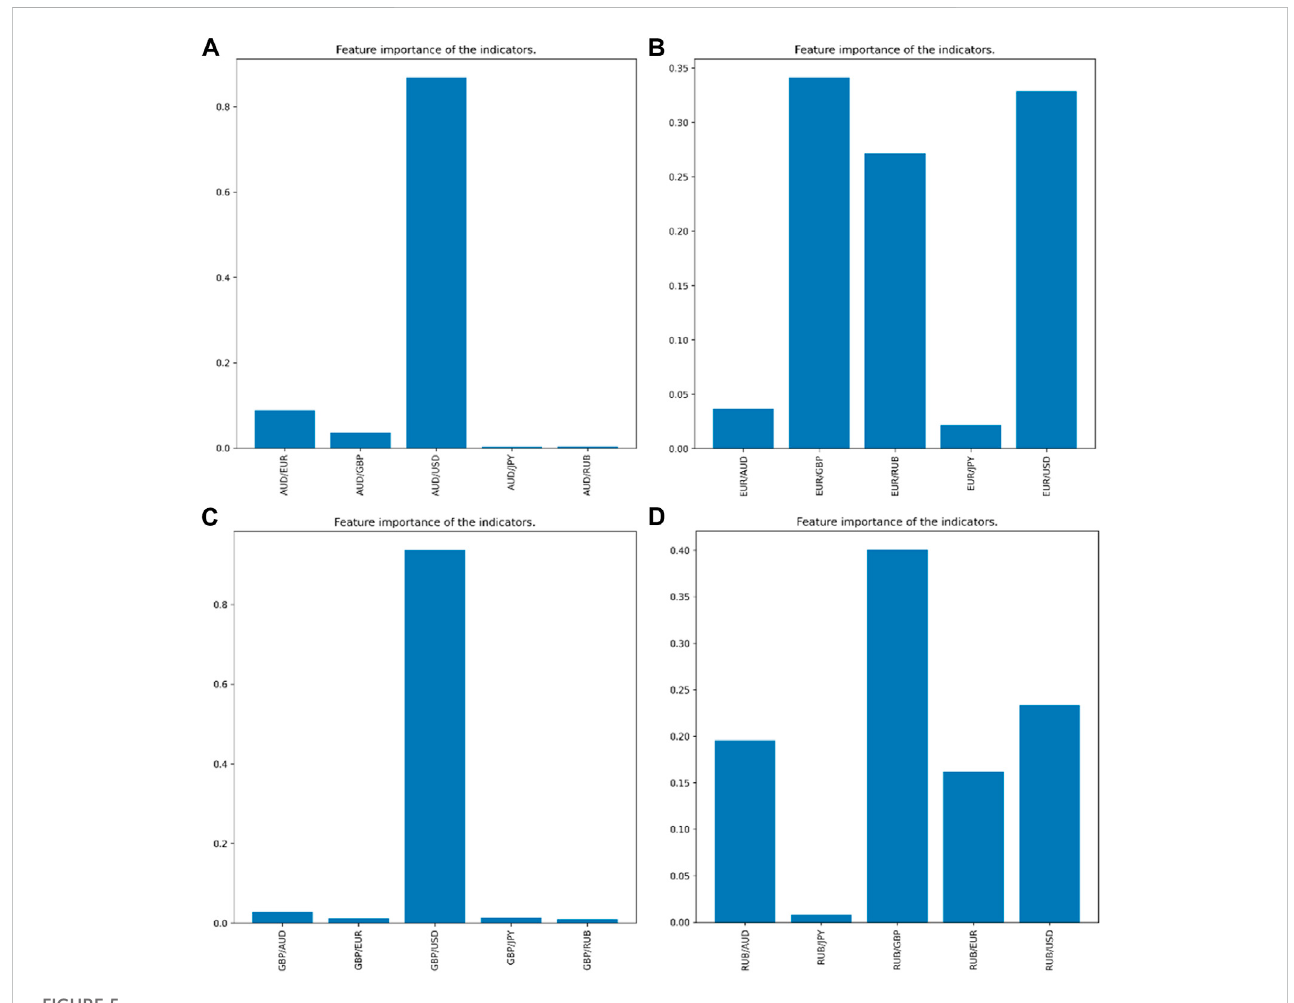
FIGURE 5 Random forest feature importance